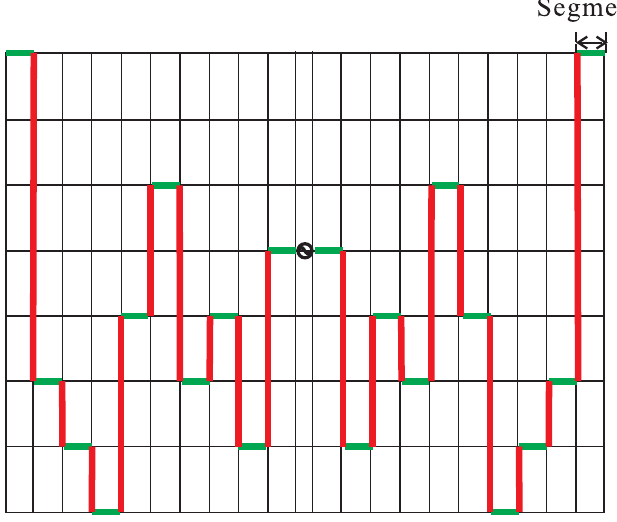
Figure 4. Design concept of a meandered dipole antenna.